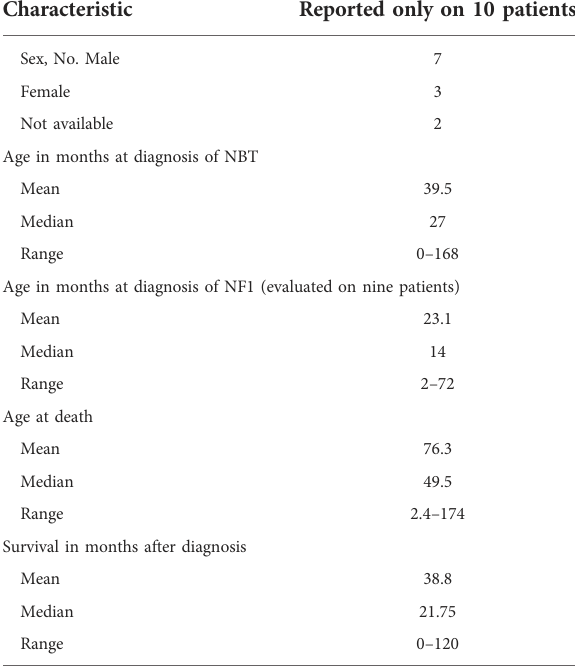
TABLE 5 Demographic information of the case